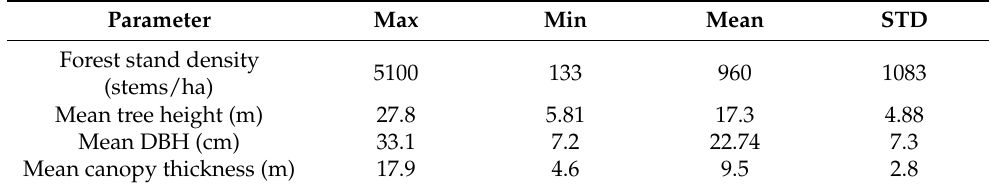
Table 1. Information on the sample plots, including the maximum (Max), minimum (Min), mean and standard deviation (STD) of the forest stand density, mean tree height, mean DBH and mean canopy thickness.